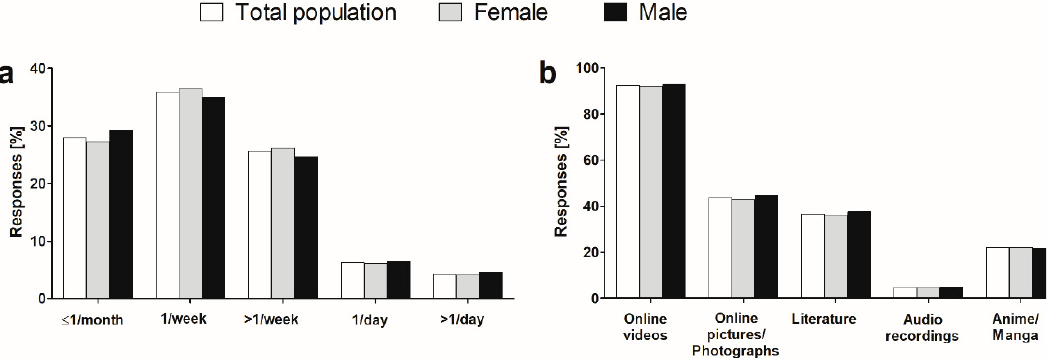
Figure 1. Frequency of pornography consumption ( a ) and its forms ( b ) in the surveyed group of studied university students ( n = 4260).